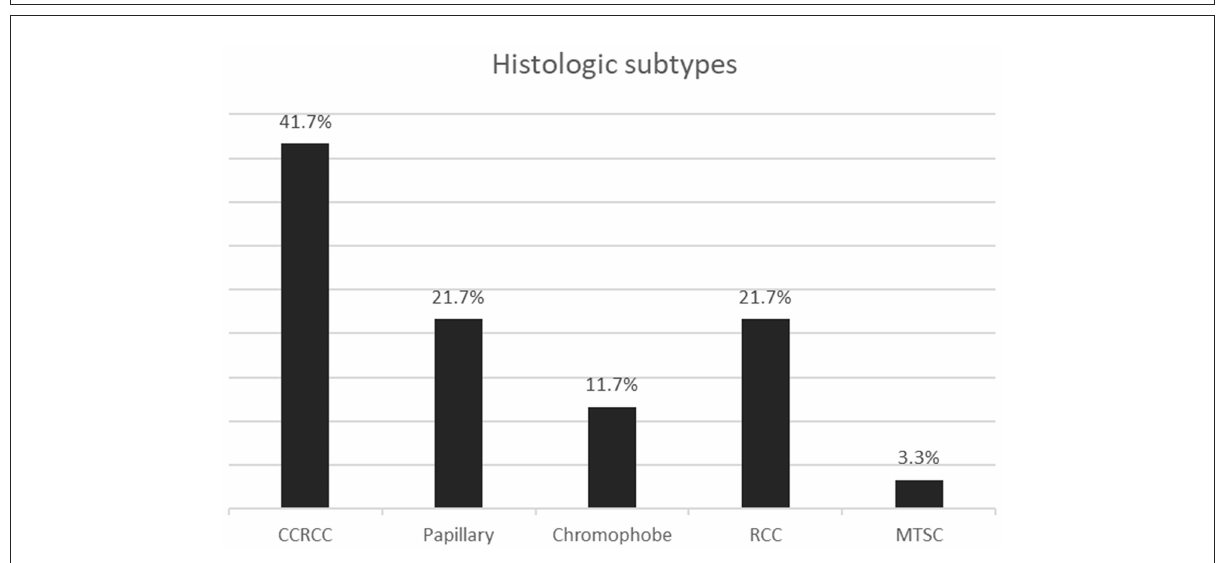
FIGURE2 Bar graph showing the histologic subtypes of renal cell carcinoma. CCRCC, Clear cell; RCC, Renal cell carcinoma not otherwise specified; MTSC, Mucinous tubular and spindle